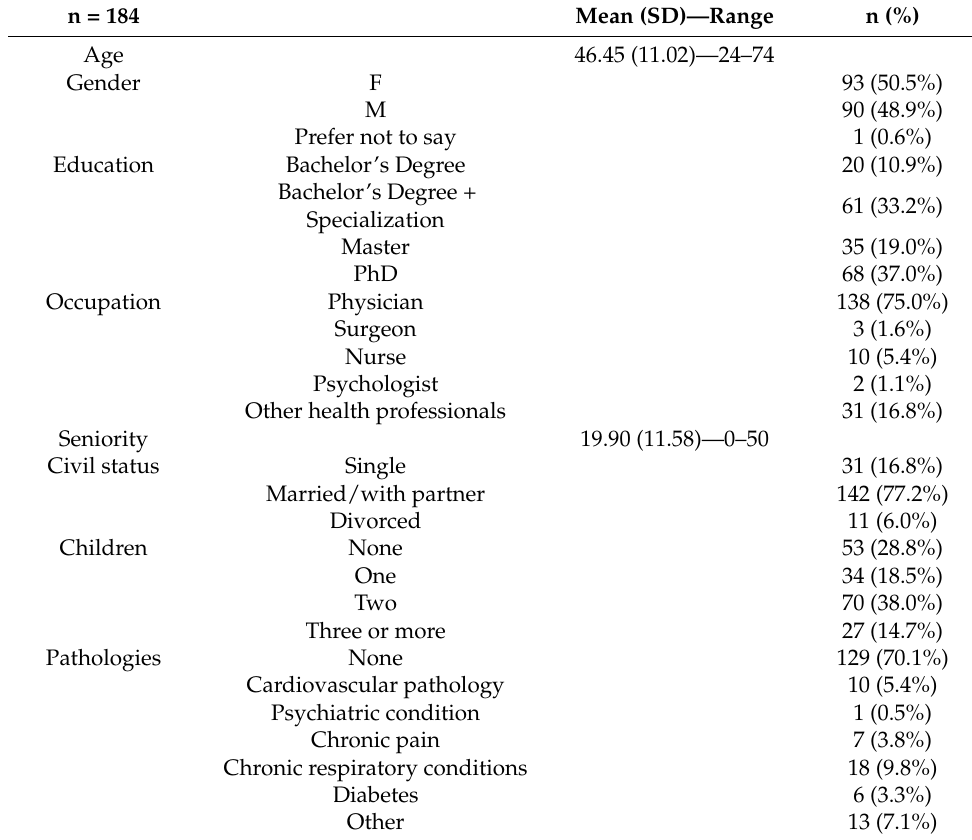
Table 1. Demographic characteristics.